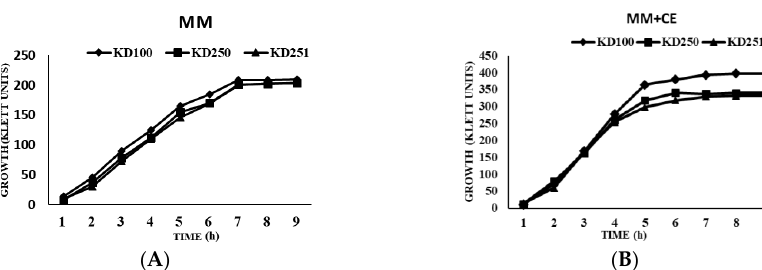
Figure 1. Growth curves of P. carotovorum strain KD100 and its wcaG mutants KD250, KD251. Bacterial cultures were grown in MM ( A ) and MM + CE ( B ) media. Growth was measured with the Klett colorimeter in Klett units. Microorganisms 2019 , 7 , x FOR PEER REVIEW